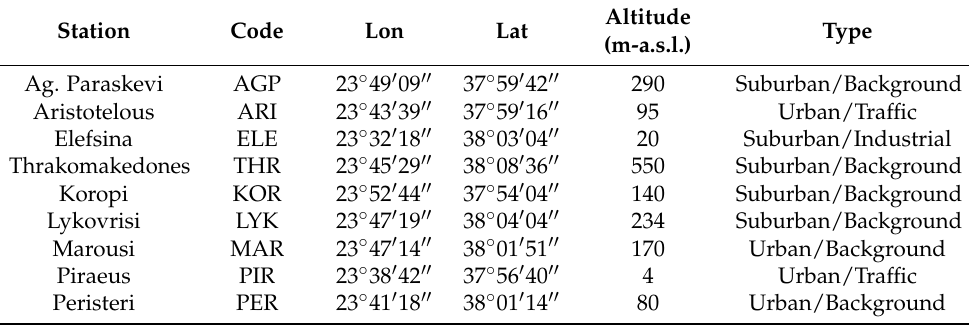
Figure 1. The Attic peninsula and the locations of the air quality monitoring stations. Table 1. Air quality monitoring stations, their code names, and important